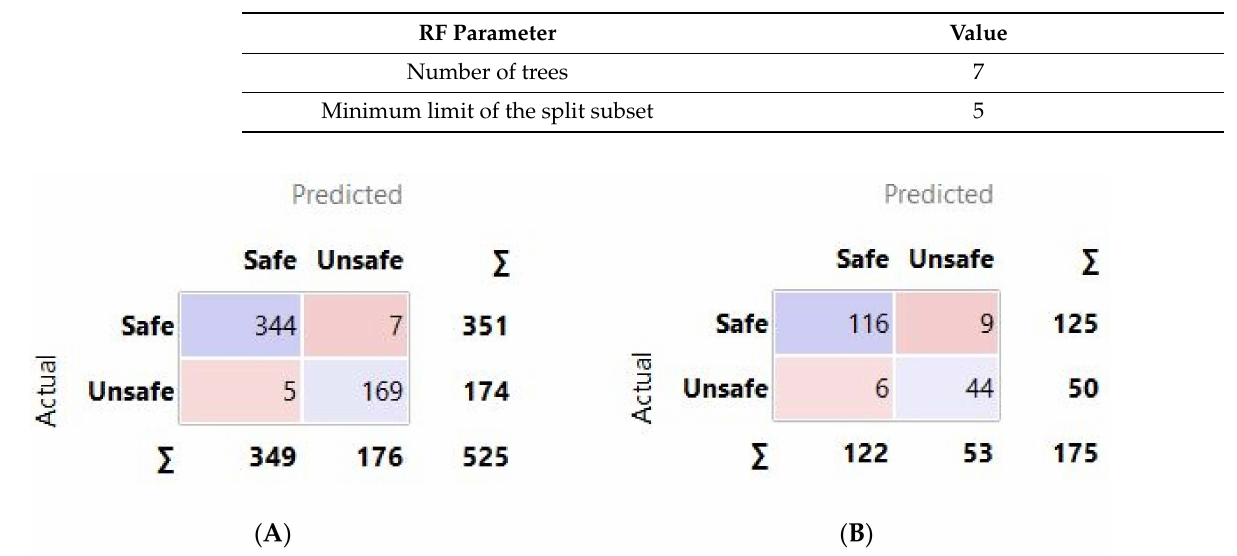
Table 5. The optimal parameters obtained by the RF model.